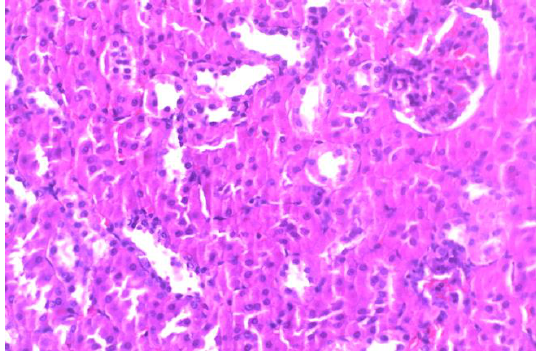
Fig. 4: The microscopical appearance of a normal rat kidney shows the kidney's typical structure (black asterisk). H&E, 400